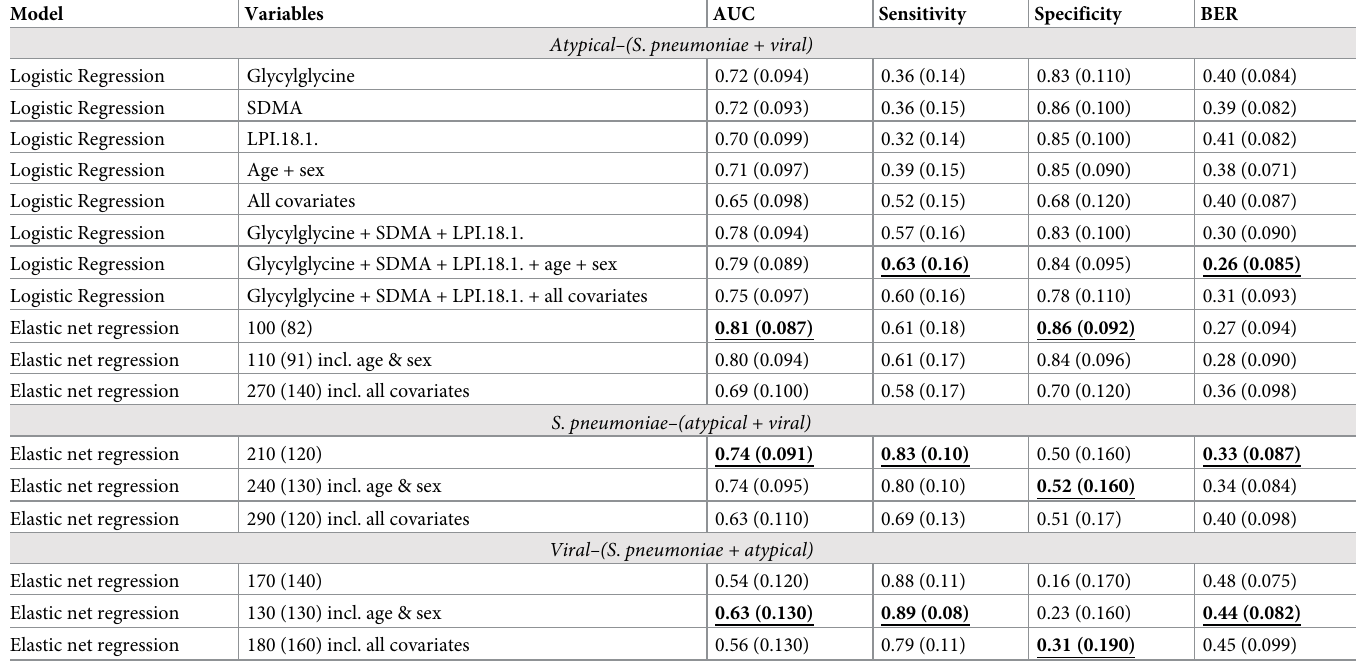
Table 3. Results from the logistic regression and elastic net regression models that were tested in a fivefold cross-validation with 100 repeats.